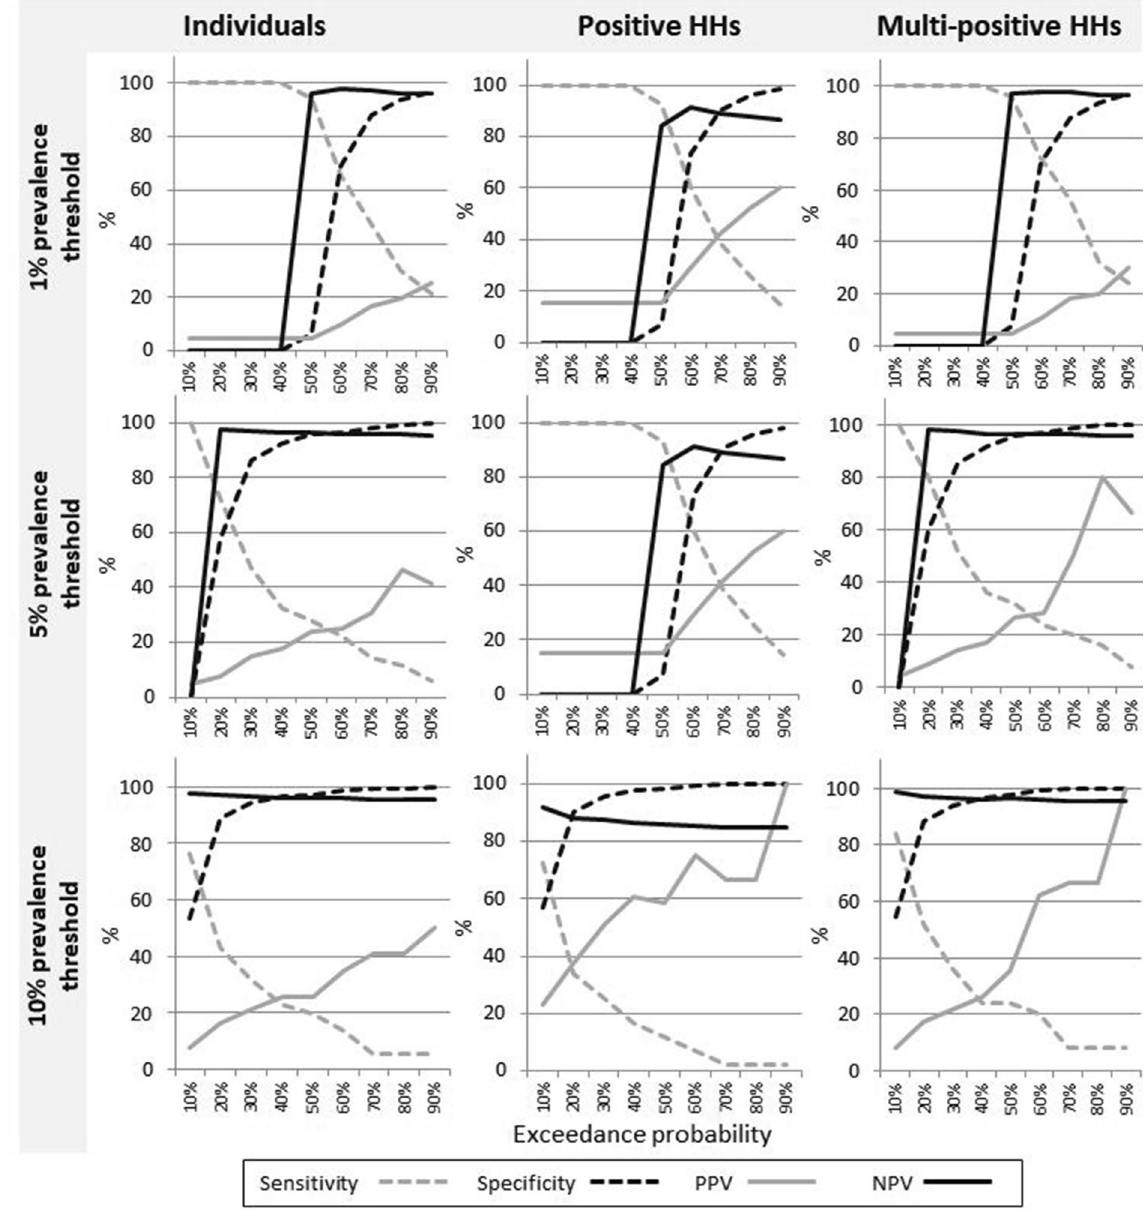
Figure 3. Model performance metrics with varying prevalence cut-offs and exceedance probability thresholds for defining predicted high risk locations. Sensitivity, specificity, positive predictive value, and negative predictive value are shown for individuals, positive households, and multi-positive households at prevalence cut-offs of 1%, 5% and